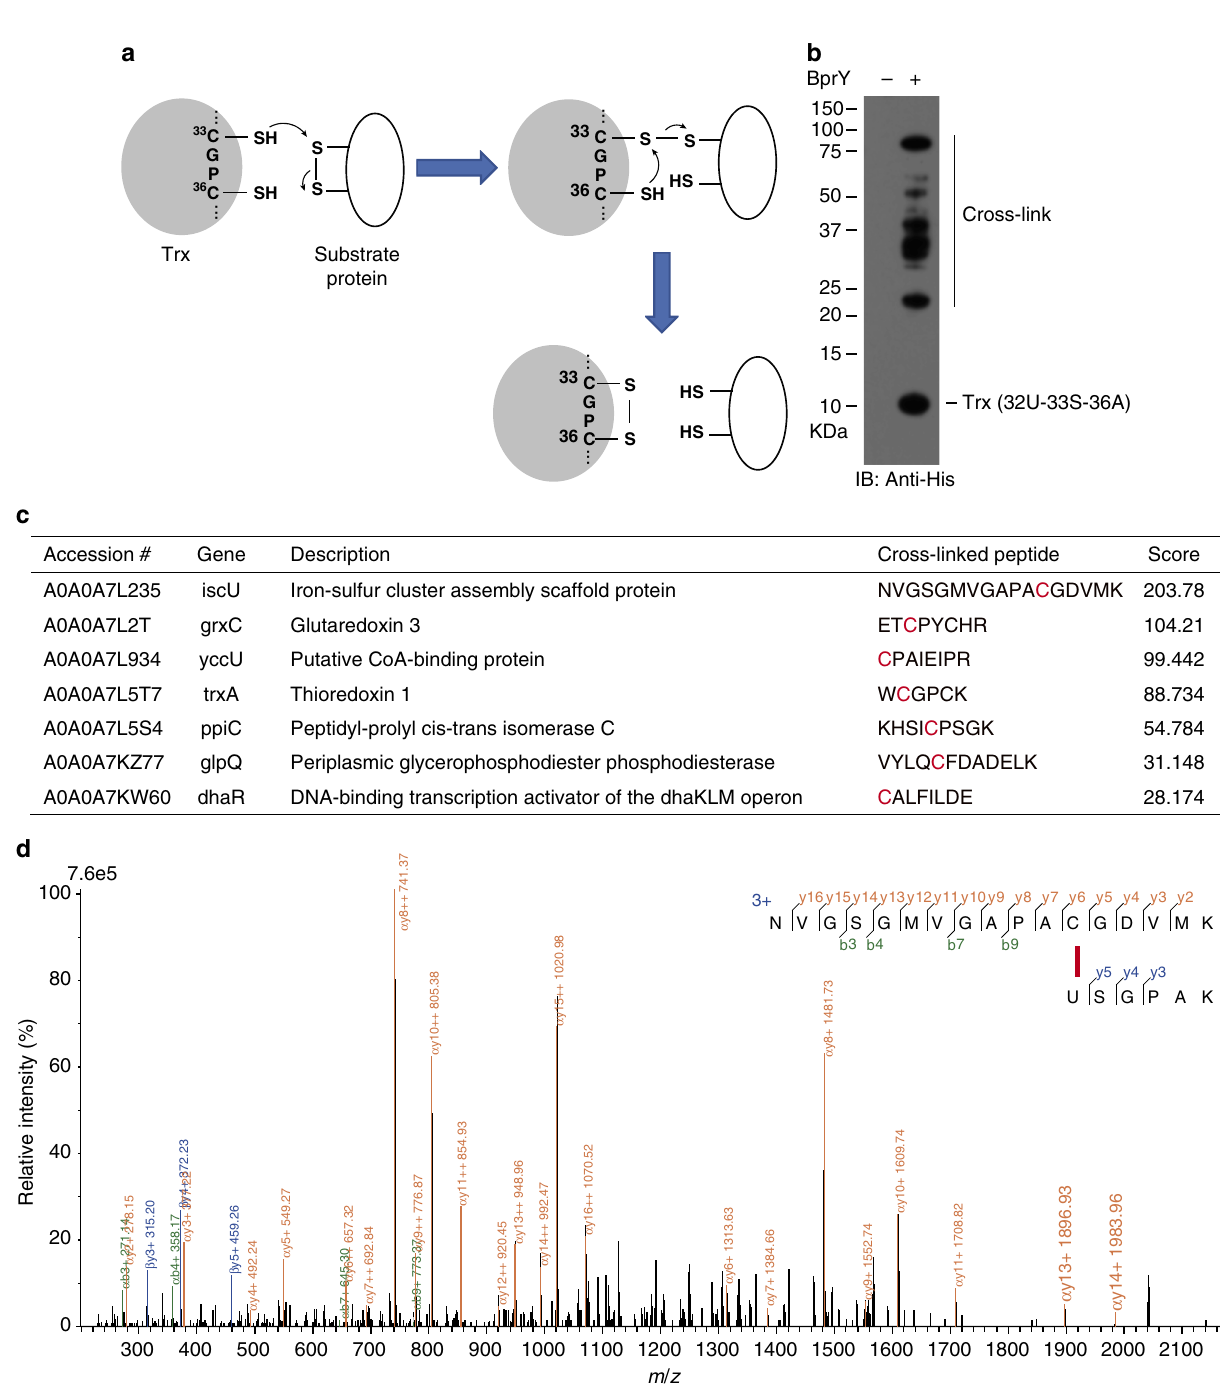
Fig. 4 GECX-MS to capture and identify Trx-interacting proteins in E. coli . a Schematic illustration of disul fi de reduction by thioredoxin (Trx). b Western blot of cell lysate of E. coli cells expressing Trx1(32BprY-33S-36A), showing multiple endogenous proteins crosslinked to Trx1. c List of proteins crosslinked to Trx1(32BprY-33S-36A) in E. coli cells that have the crosslinked peptides identi fi ed. The crosslinked Cys residues are highlighted in red. d Mass spectrum of cross-linked peptide between iscU and Trx1. U represents BprY in the peptide sequence. The mass spectra for other crosslinked proteins are provided in Supplementary Figure